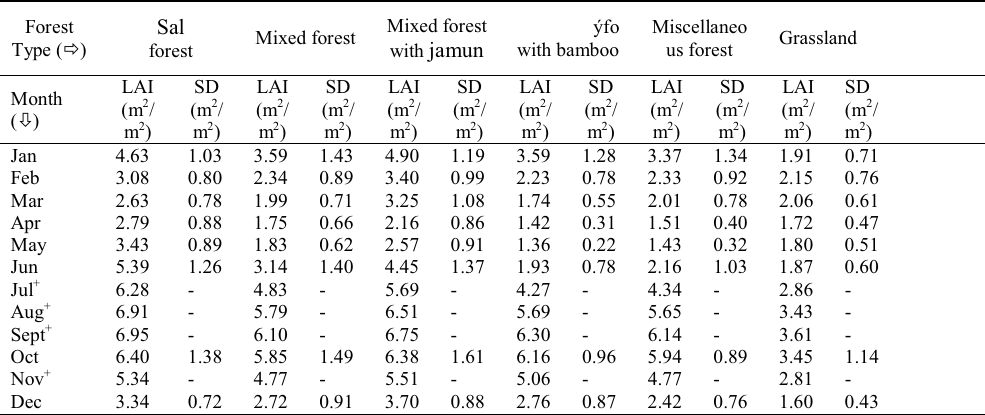
Table 2. Temporal variability of LAI in tropical deciduous forest species, retrieved from LISS III data ( + Fitted LAI values, SD: Standard Deviation) S.NO Forest Type NPP (t/ha/yr) Sal forest